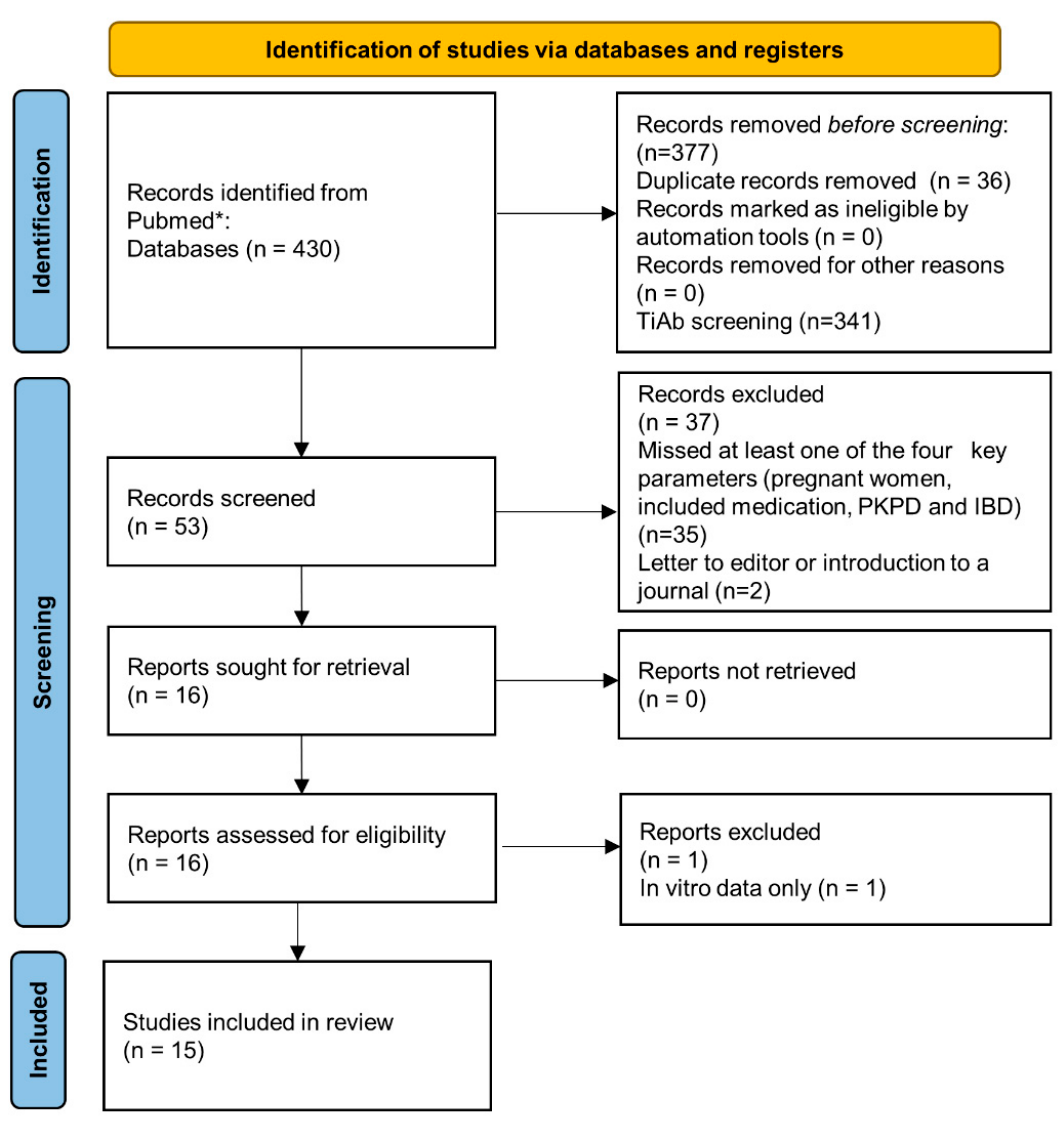
Figure 1. PRISMA flow diagram [8].